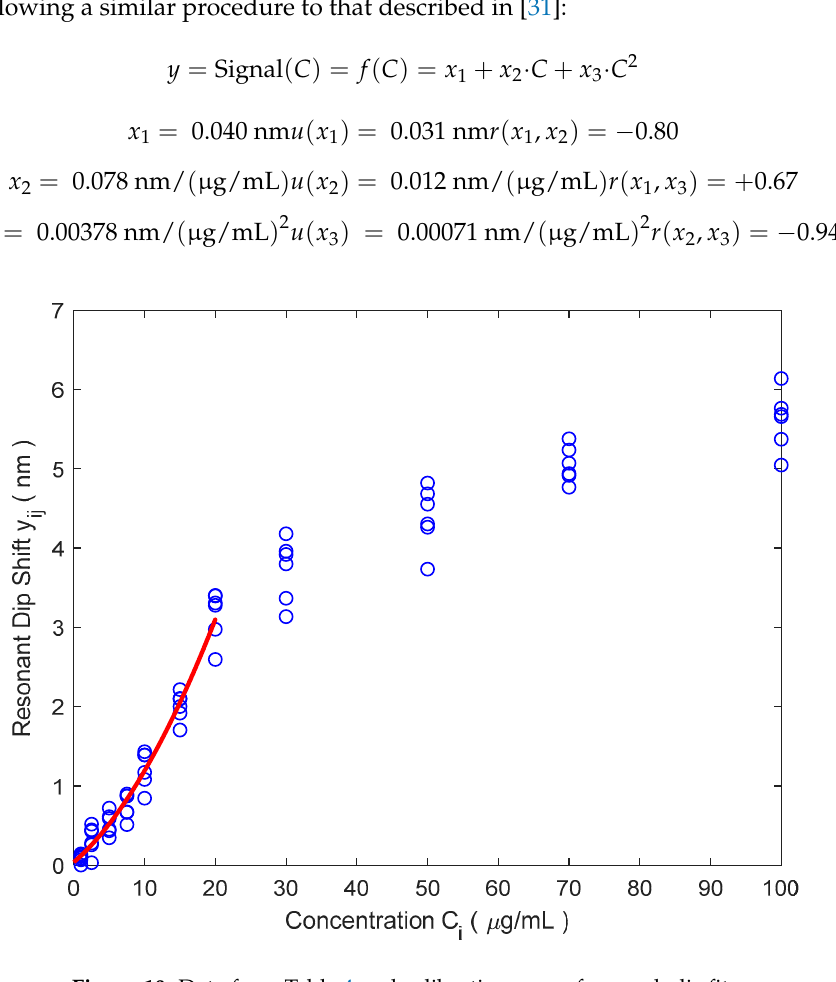
Figure 10. Data from Table 4 and calibration curve for parabolic fit.